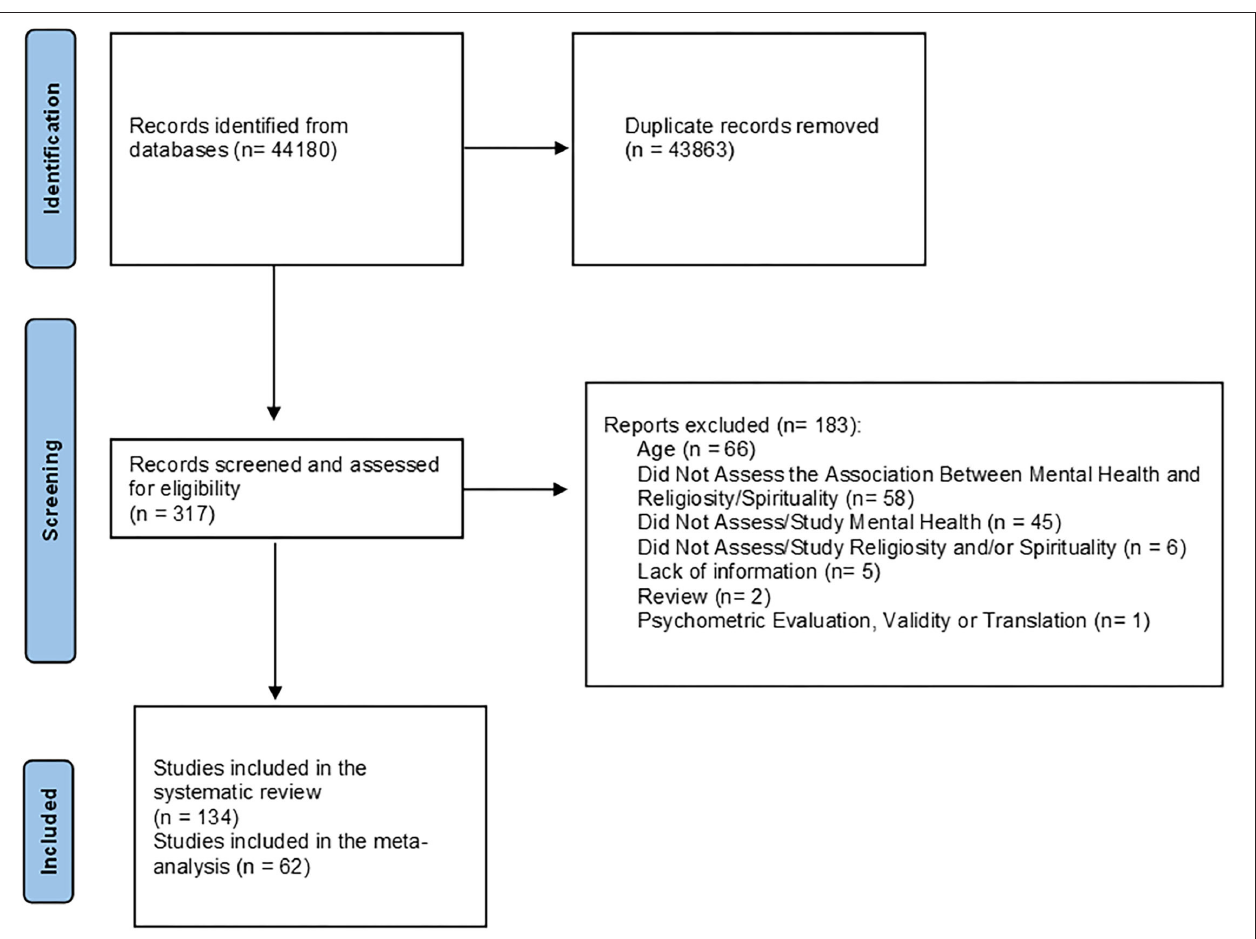
FIGURE 1 | Flowchart of the present